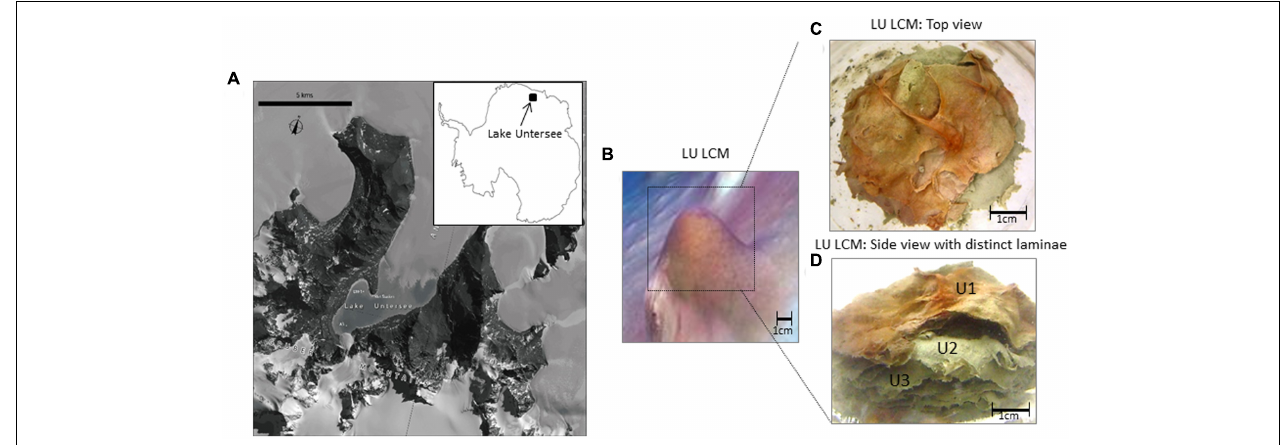
FIGURE 1 | Geographical location, structure and laminae of a large conical mat of Lake Untersee, Antarctica. (A) Geographical location and satellite image map of Lake Untersee (71.34 ◦ S 13.27 ◦ E) Antarctica. (Satellite imagery copyright DigitalGlobe, Inc. Provided by NGA Commercial Imagery Program). (B) Underwater photograph of a large conical microbial mat in Lake Untersee. (C) Large conical microbial mat in Lake Untersee used in this study showing the top layer with bright-colored predominantly pigmented cyanobacteria. (D) Individual lamina of a large conical microbial mat from Lake Untersee used in this study. Notice the top layer consisted of bright colored pigmentation primarily from cyanobacteria. (LU, Lake Untersee; LCM, Large Conical Mat); (U1 = top lamina; U2 = middle lamina, and U3 = inner